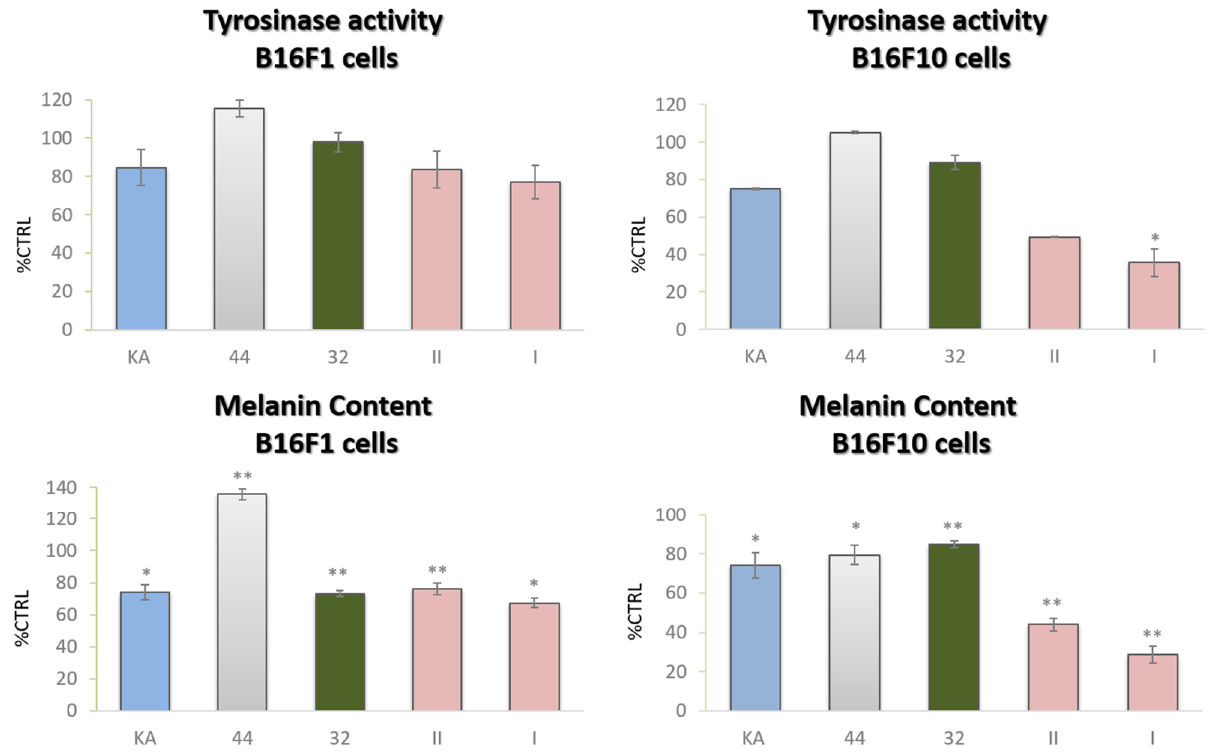
Figure 5. Effect of the four selected compounds on intracellular tyrosinase activity and melanin cellular content (Bars, ±SD, * p < 0.05; ** p < 0.01, n = 2). cellular content (Bars, ± SD, * p < 0.05; ** p < 0.01, n =